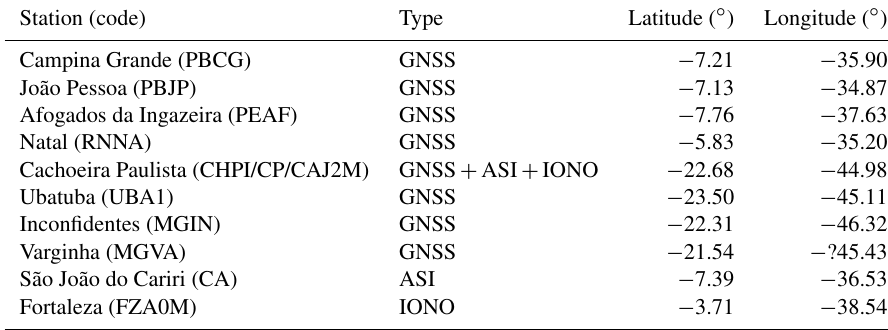
Table 2. Latitude, longitude, and type of instrument present at the sites used in this study. Station (code) Type Latitude ( ◦ ) Longitude ( ◦ ) Campina Grande (PBCG) GNSS − 7.21 − 35.90 João Pessoa (PBJP) GNSS − 7.13 − 34.87 Afogados da Ingazeira (PEAF) GNSS − 7.76 − 37.63 Natal (RNNA) GNSS − 5.83 − 35.20 Cachoeira Paulista (CHPI/CP/CAJ2M) GNSS + ASI + IONO − 22.68 − 44.98 Ubatuba (UBA1) GNSS − 23.50 − 45.11 Inconfidentes (MGIN) GNSS − 22.31 − 46.32 Varginha (MGVA) GNSS − 21.54 − ?45.43 São João do Cariri (CA) ASI − 7.39 − 36.53 Fortaleza (FZA0M) IONO − 3.71 −